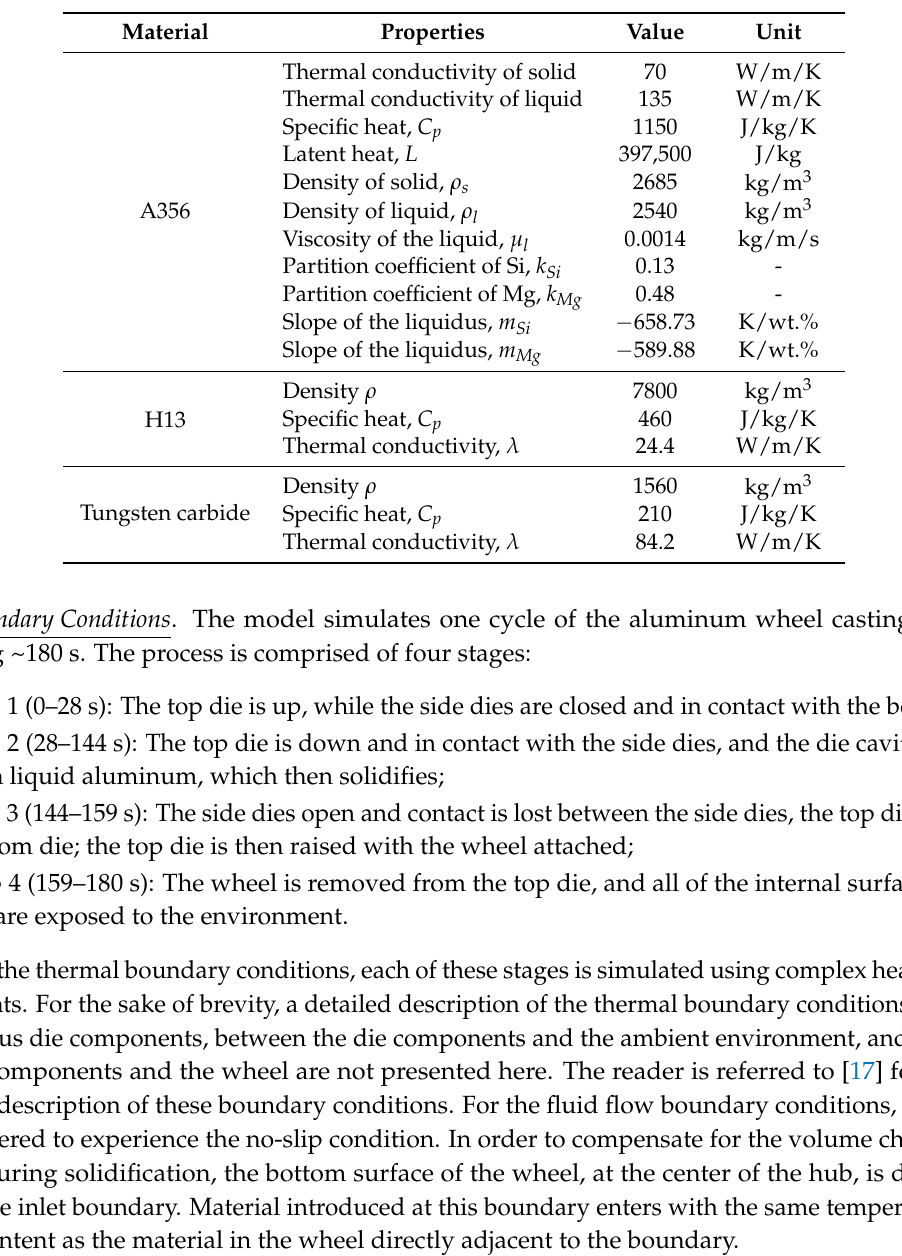
Table 1. Thermophysical properties used in the numerical